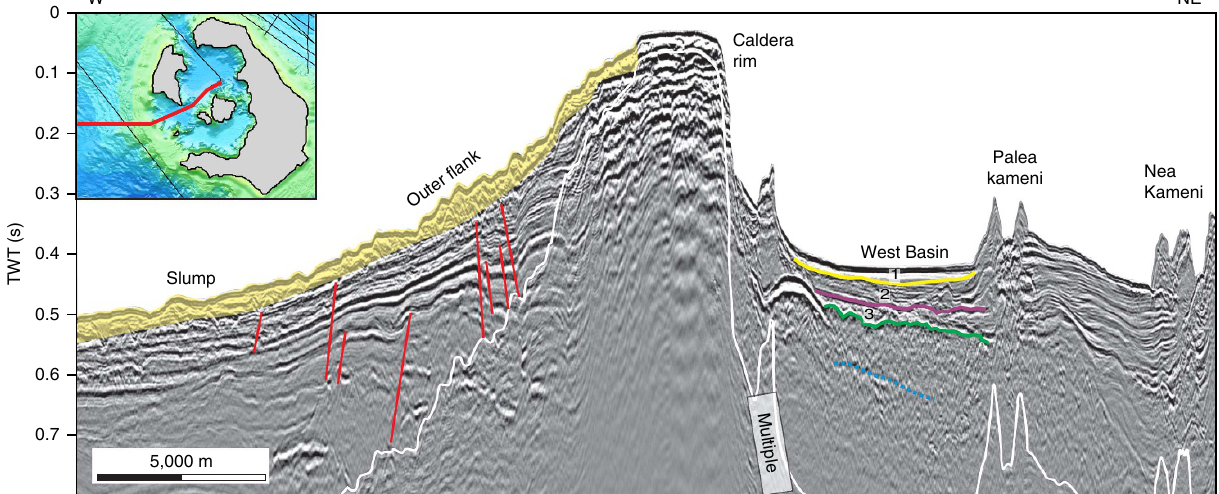
Figure 4 | Interpreted W-NE striking multi-channel reflection seismic profile across the SW strait. This profile cuts across the outer edge of the western basin of Santorini caldera, as shown in the inset. Stratigraphic units 1–3 of ref. 10 are shown numbered; The dotted dark blue line indicates a deep, but poorly defined reflector; faults are shown in red. A TWT (two-way travel time) interval of 0.1s corresponds approximately to a water depth interval of 75m or a sediment interval of 100m. Please refer to Supplementary Fig. 2 for the uninterpreted seismic profile.